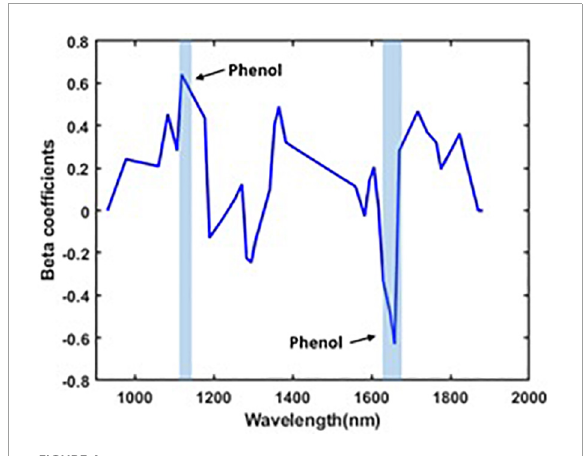
FIGURE4 Beta coefficients for SWIR spectra after waveband reduction.